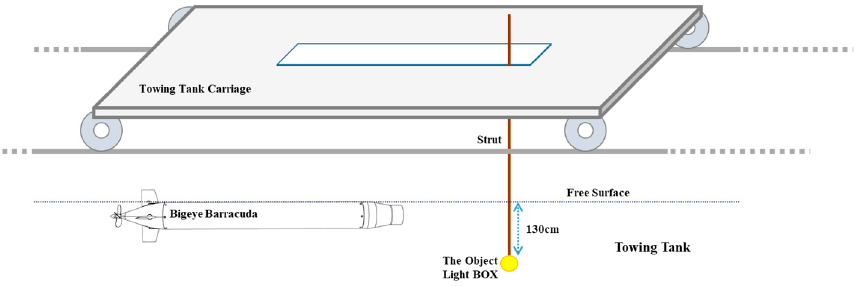
Figure 13. Object-tracking tests of Bigeye Barracuda in National Cheng Kung University’s towing tank.